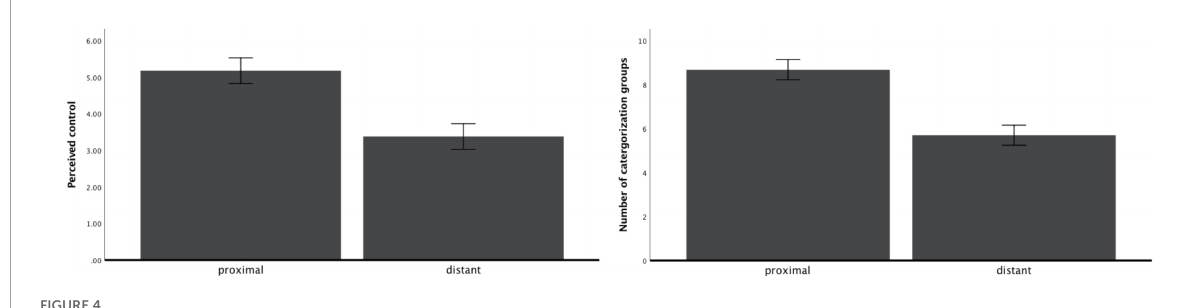
FIGURE4 Perceived control and number of groups as a function of psychological distance (study